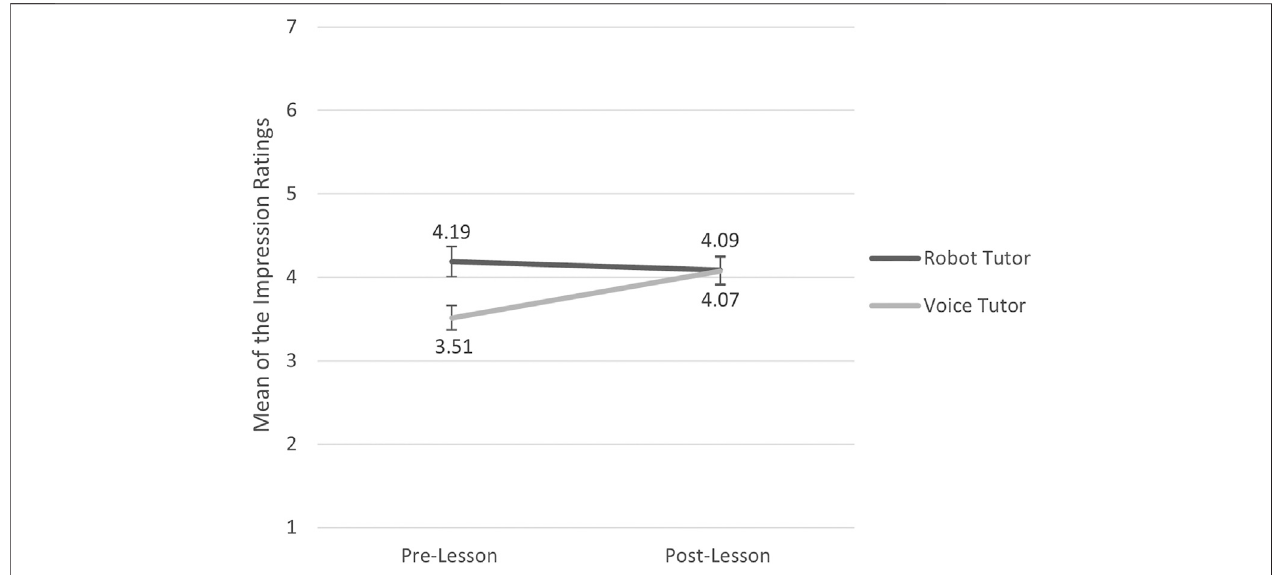
FIGURE 5 | Mean ratings of the impression survey in the robot tutor and voice tutor conditions before and after the lesson. N (cid:1) 100 for pre-lesson and N (cid:1) 99 for post-lesson. The highest possible score for each test was 7. The error bars indicate the standard errors.